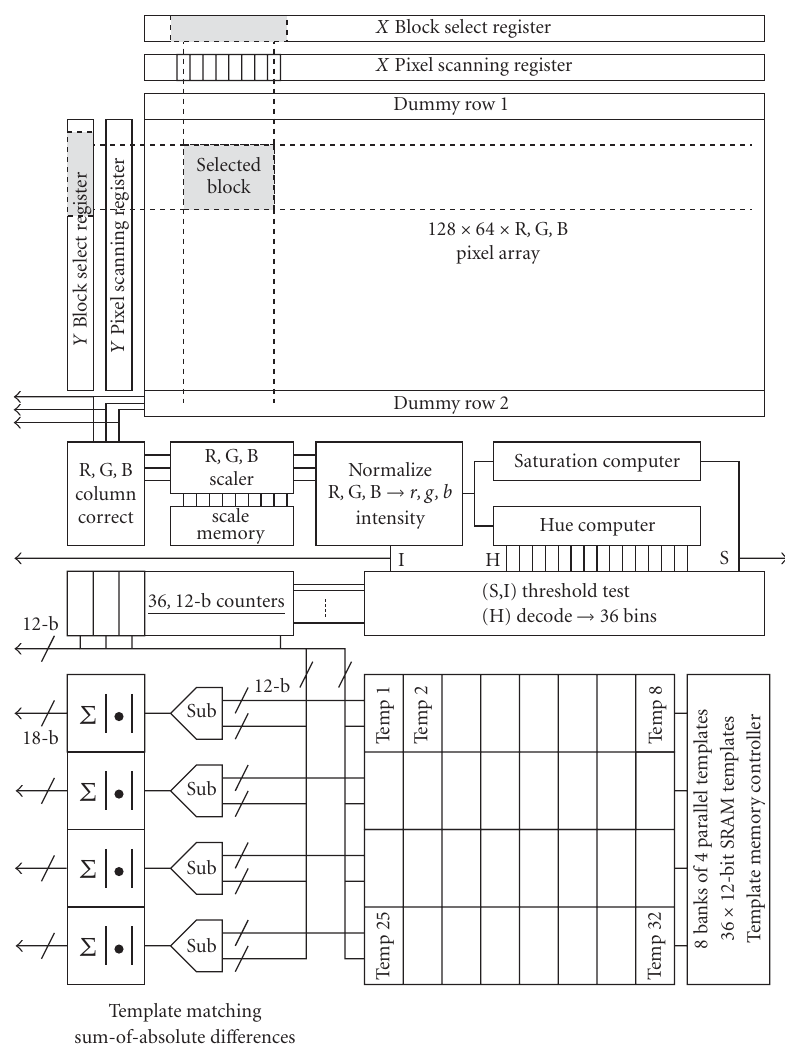
Figure 5: Computational and physical architecture of the